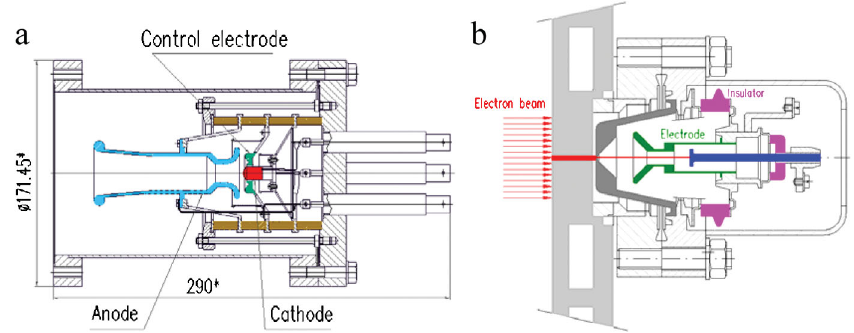
FIG. 9. (Color) (a) Mechanical design of the flattop gun; (b) pin-hole collector assembly for beam profile measurements on the test bench.